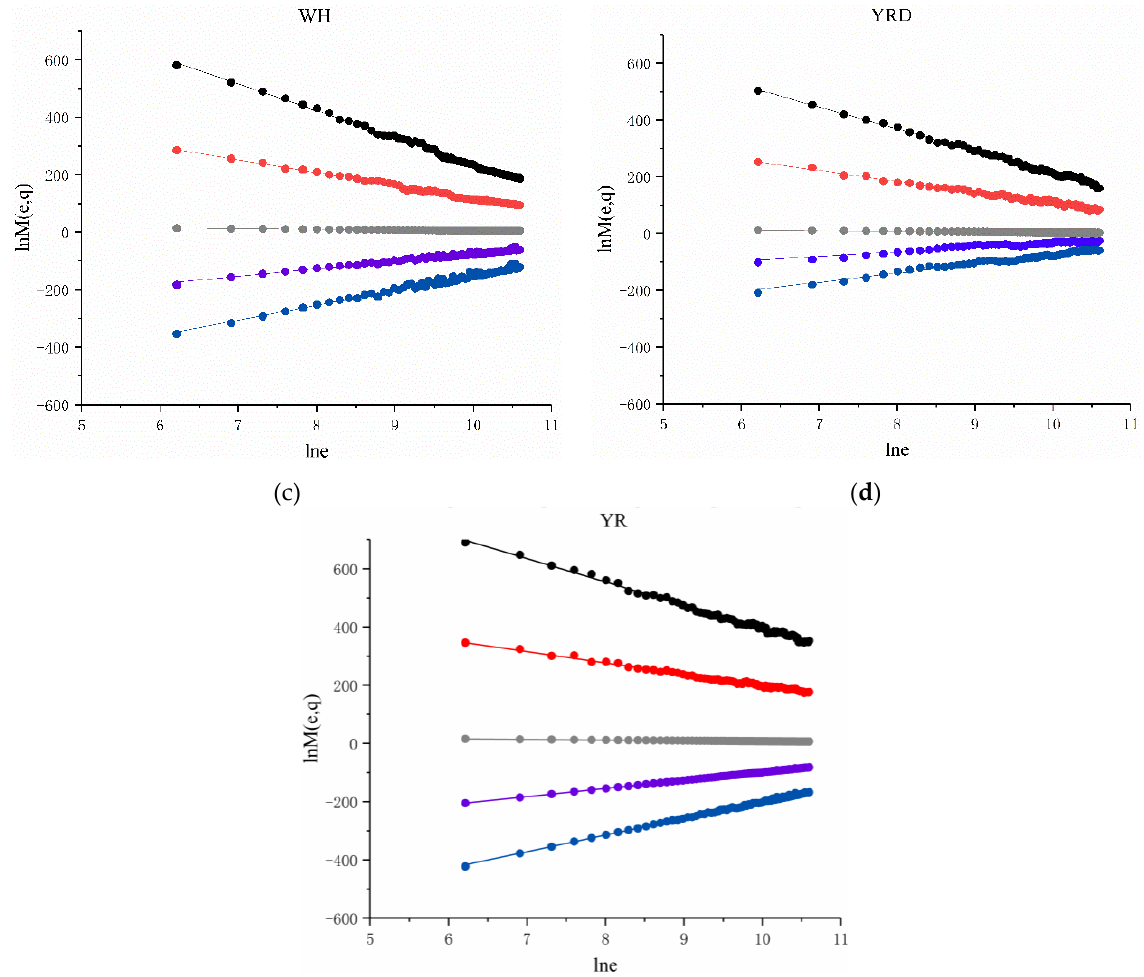
Figure 4. The ln𝑀(𝑒,𝑞) ～ ln𝑒 relationships of ( a ) The Yellow River Mainstream Basin (YRM); ( b ) The Fenhe River Basin (FH); ( c ) The Weihe River Basin (WH); ( d ) The Yellow River Downstream Basin (YRD); and ( e ) The Yellow River Basin (YR).